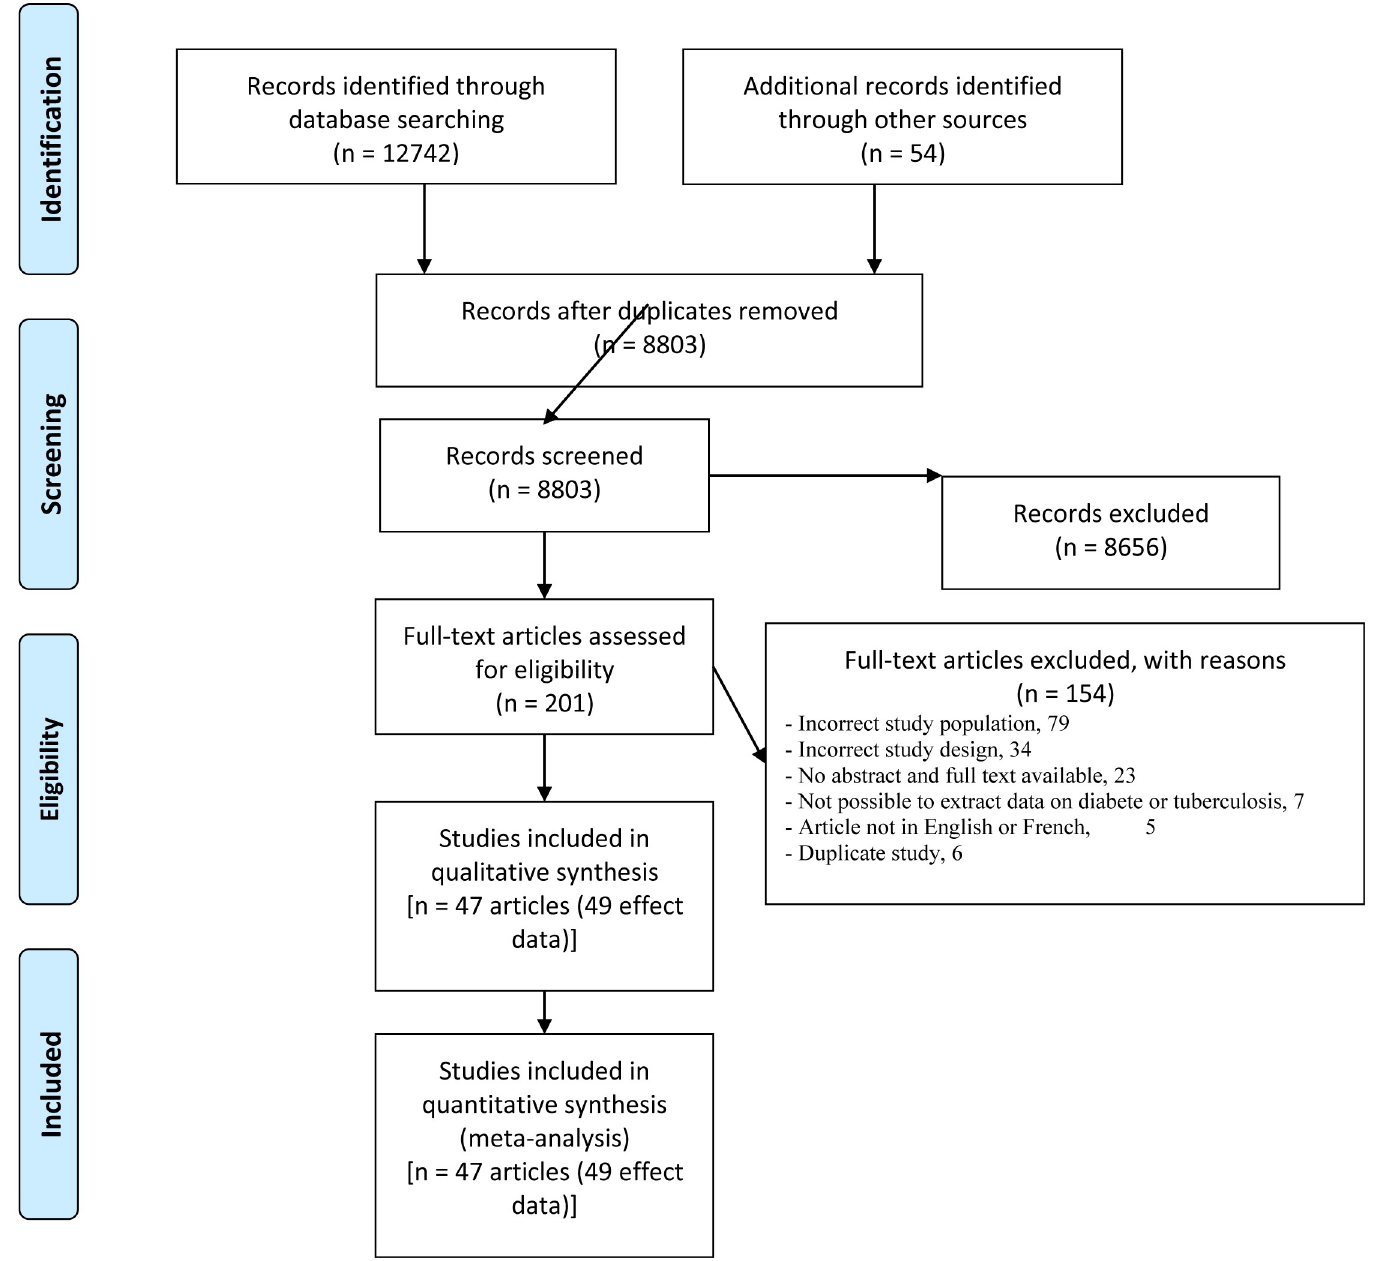
Fig 1. PRISMA flow-chart of studies selected for the meta-analysis. https://doi.org/10.1371/journal.pone.0261246.g001 different regions of the world and more particularly in China (16/49) and the United States of America (11/49). High-income countries (26/49) were the most represented and only one study was conducted in low-income countries [46]. The vast majority of studies recruited adults over 15 years old. Apart from studies with multiple diagnostic methods, the Interna- tional Classification of Diseases (ICD) code was the most widely used approach for DM (10/ 26) and TB (11/20). Nineteen included studies paired reference with controls with at least one parameter.